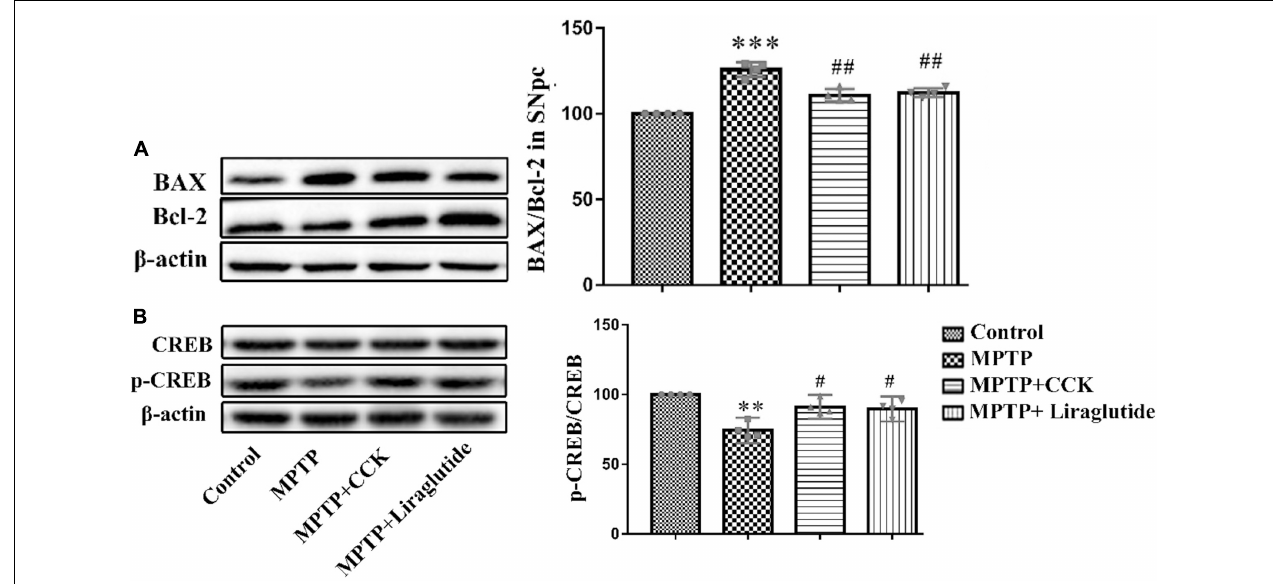
FIGURE 7 | Western blot showing the protein levels of Bax, Bcl-2 and CREB. Liraglutide and the CCK analogue reversed the increase of ratio of Bax/Bcl-2 (A) and the decrease of pCREB S133 (B) in the SNpc of mice induced by MPTP. ∗∗ P < 0.01, ∗∗∗ P < 0.001, compared with the control group, # P < 0.05, ## P < 0.01, compared with the MPTP group, n = 4 per